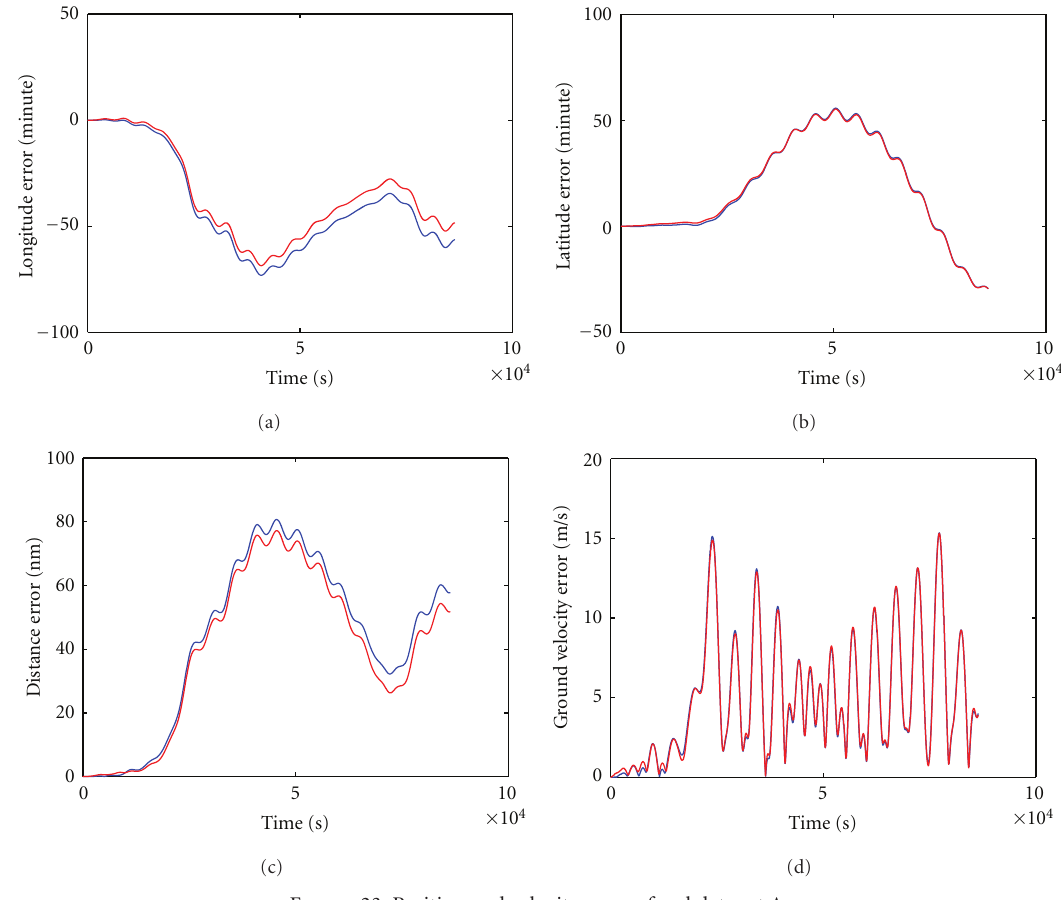
Figure 23: Position and velocity error of real data set